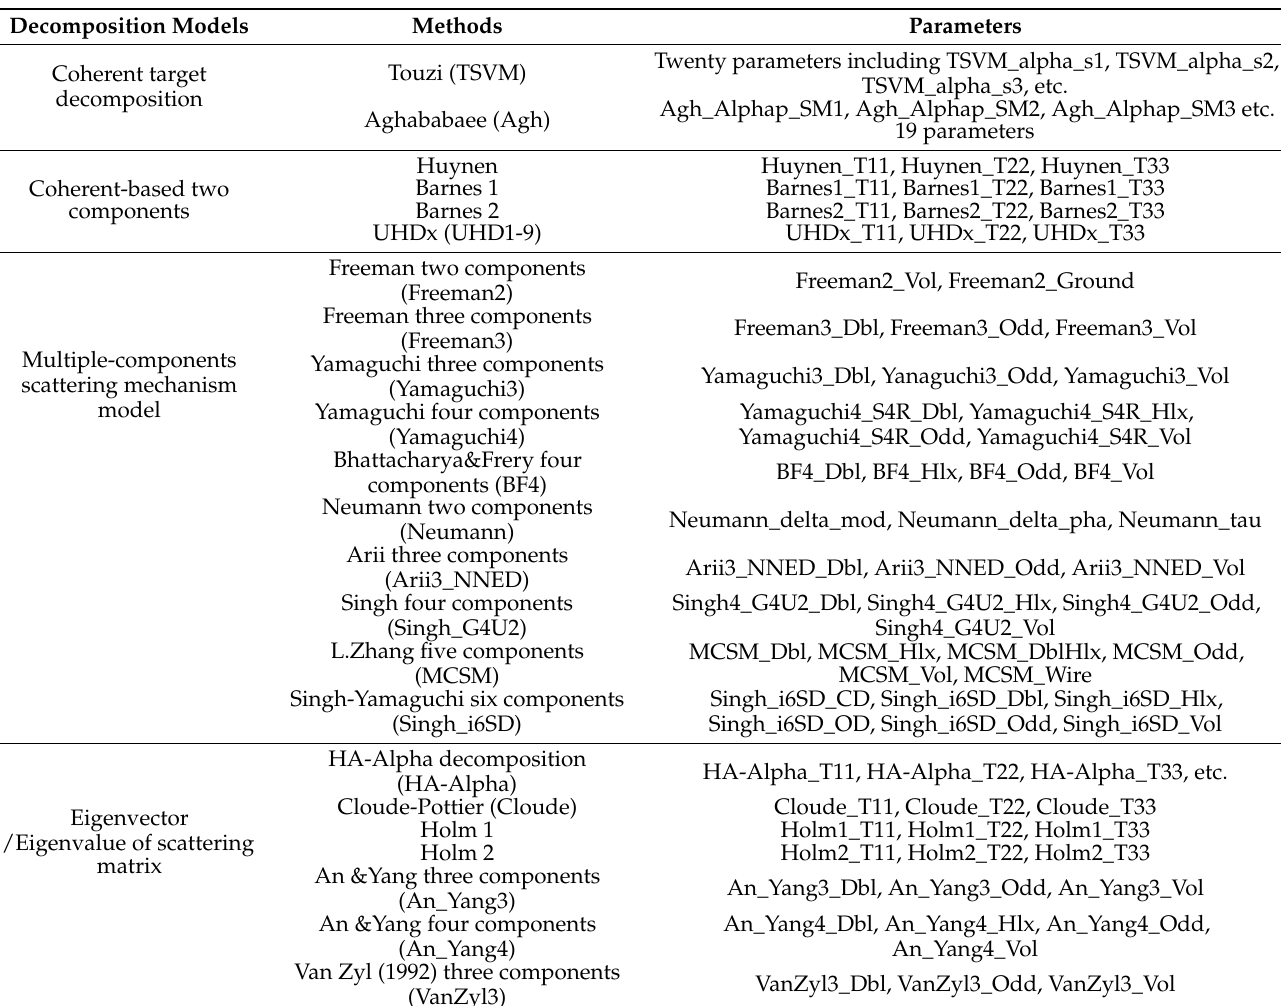
Table A1. Summary of polarimetric decomposition methods and polarimetric parameters used in this